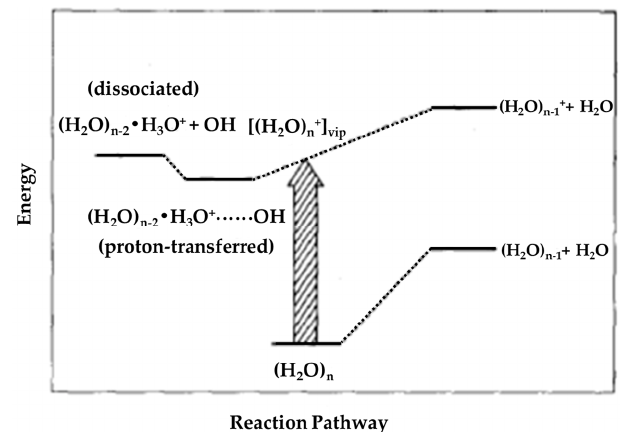
Figure 9. Schematic energy level diagram of water clusters (H 2 O) n along the reaction channels. The label “vip” stands for vertically ionized points (sic). Figure adapted from [10] with permission. Copyright 1986 American Institute of Physics.